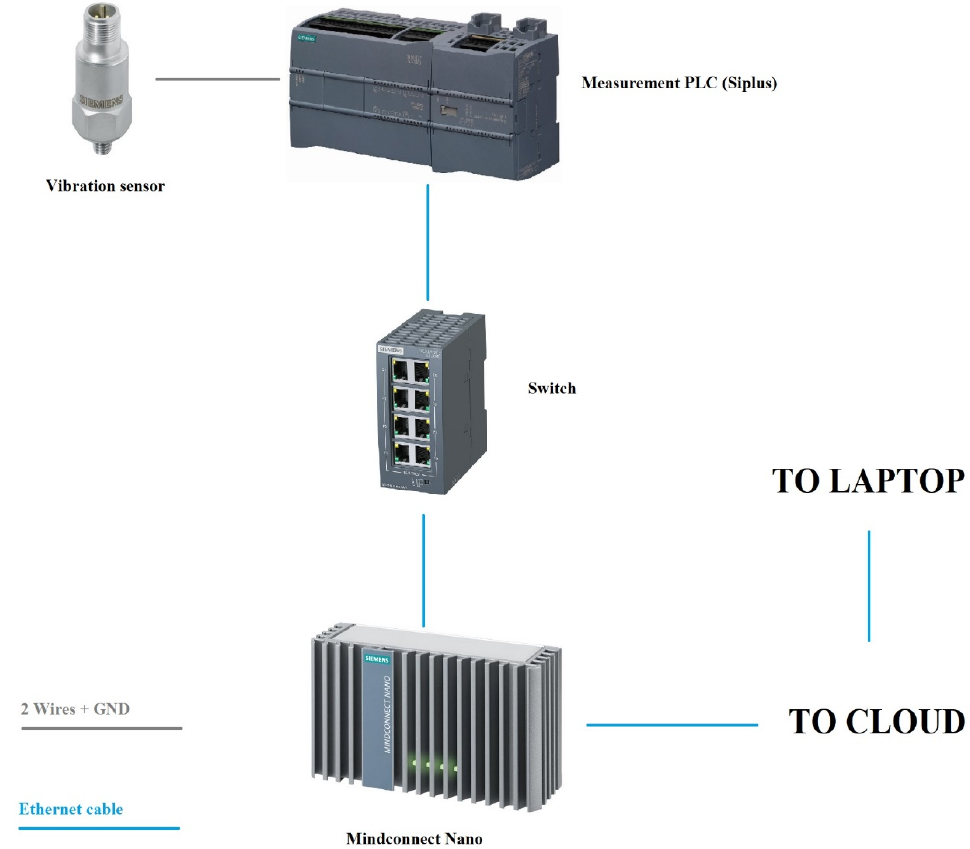
Figure 3. Data acquisition devices [33].